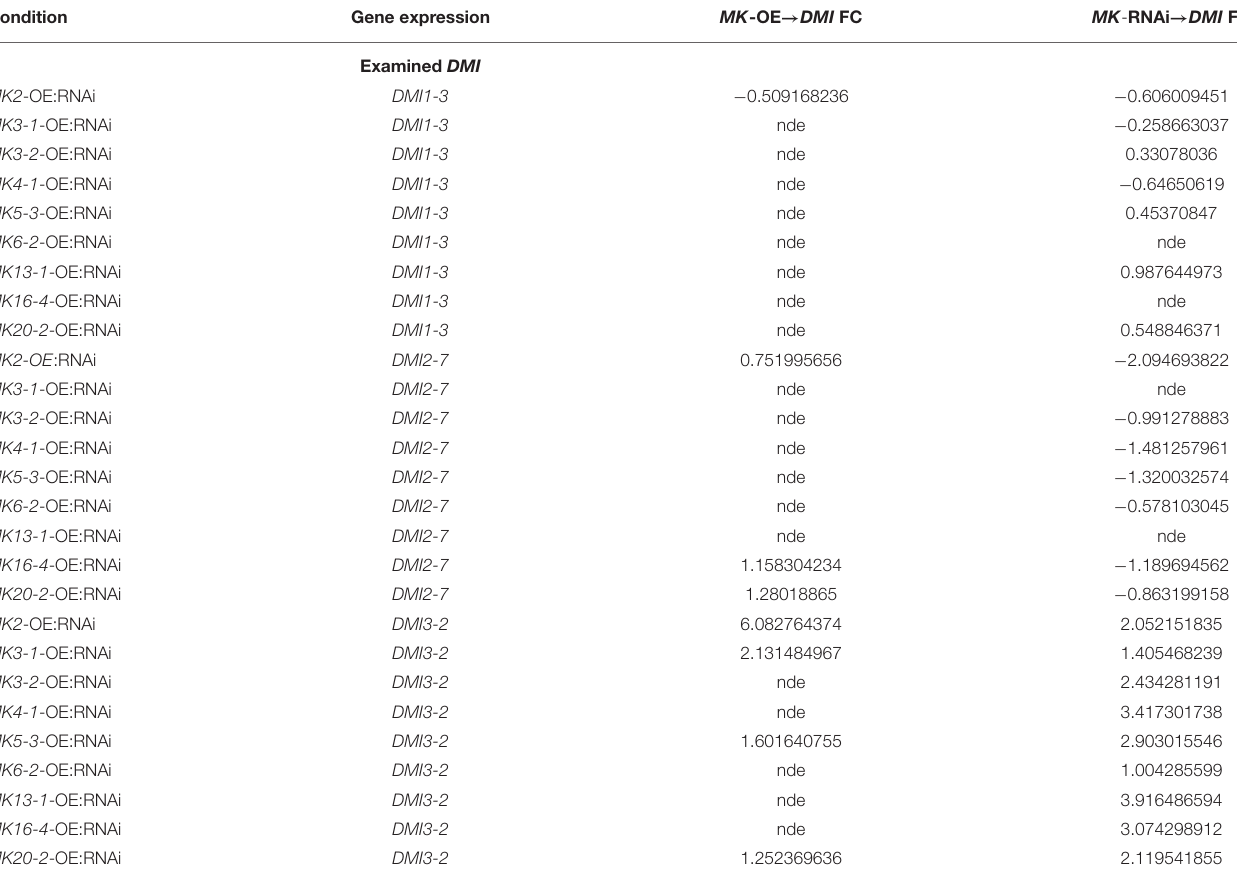
TABLE 3 | RNA-seq differential expression measurements of G. max DMI-3 , DMI2-7 , and DMI3-2 gene family members in the defense MAPK -OE and MAPK -RNAi root RNA samples as compared to the pRAP15 -ccdB (OE control) and pRAP17 -ccdB (RNAi control) samples, p < 0.001 (Wang and Wang, 2021).